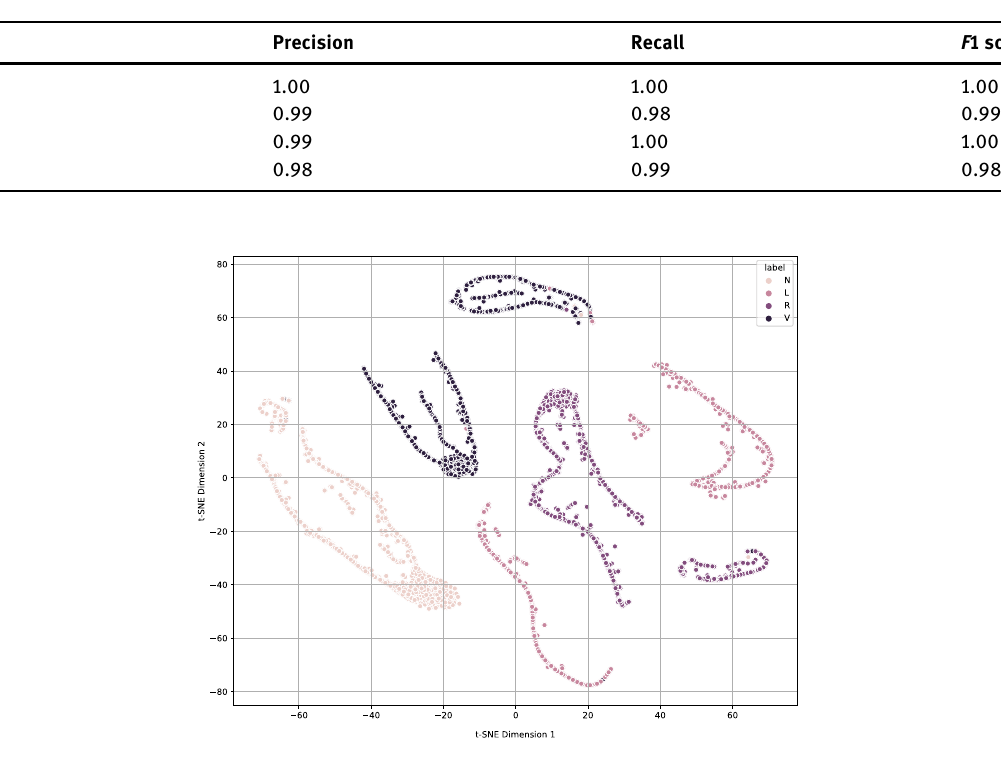
Figure 5: t - SNE visualization of the four classes N, L, R, and V.